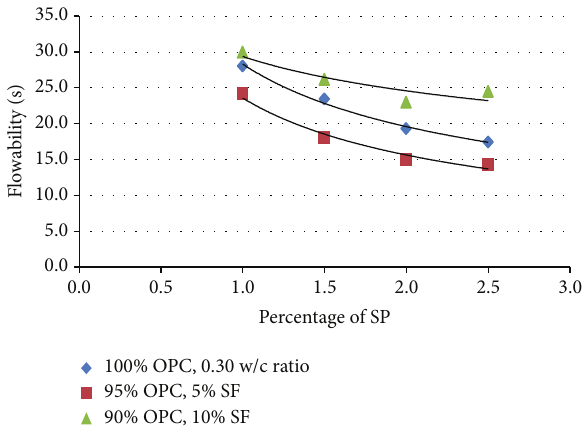
Figure 2: Influence of SP percentages on workability for 100% OPC; 95% OPC, 5% SF; and 90% OPC, 10% SF